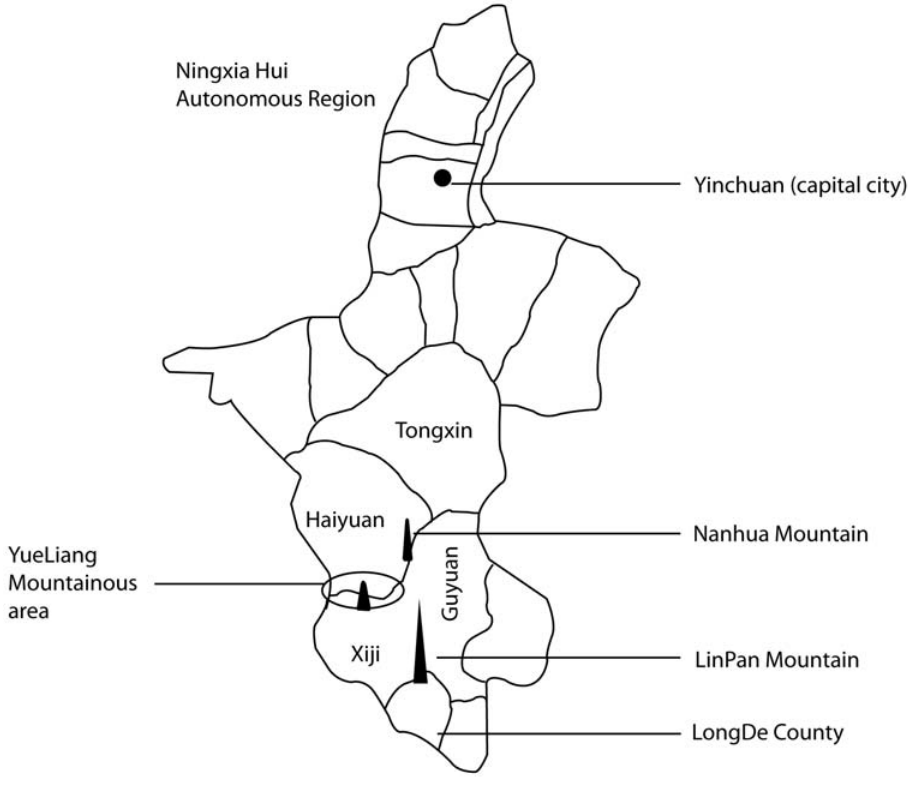
Figure 1. Map of the Yueliang Mountain area in Southern NHAR, China.